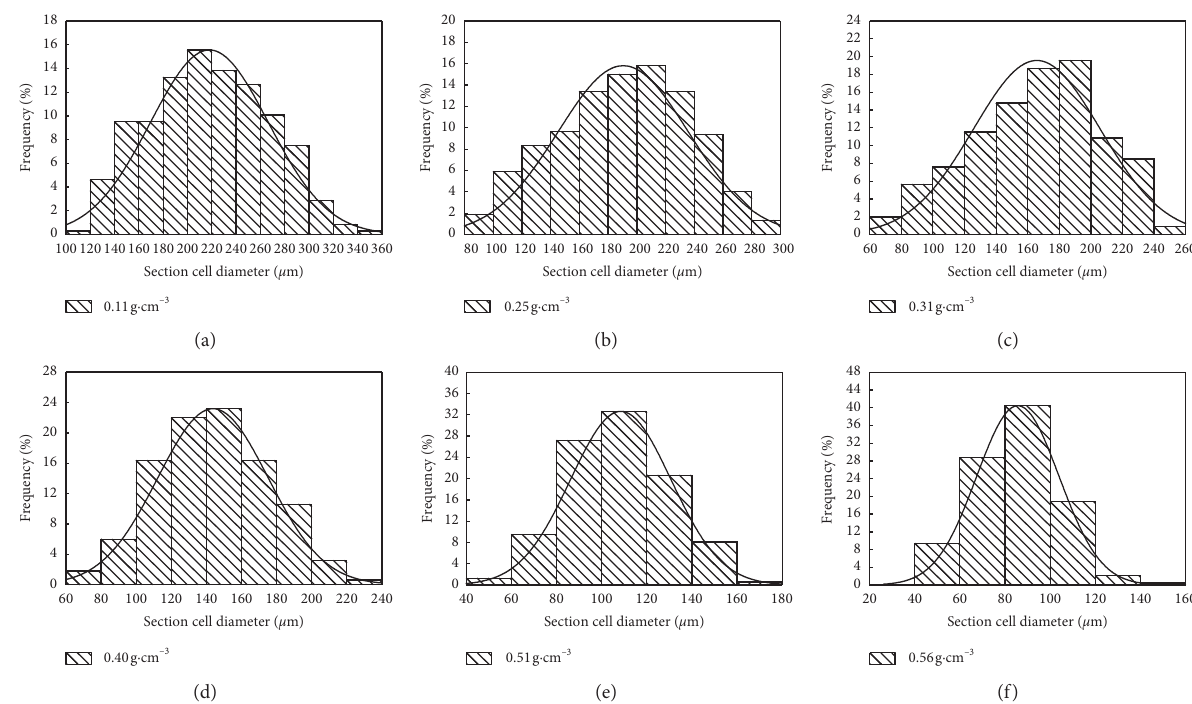
Figure 6: Section cell diameter distribution of polyurethane polymer samples. (a) 0.11g/cm 3 ; (b) 0.25g/cm 3 ; (c) 0.31g/cm 3 ; (d) 0.40 g/cm 3 ; (e) 0.51g/cm 3 ; (f) 0.56g/cm 3